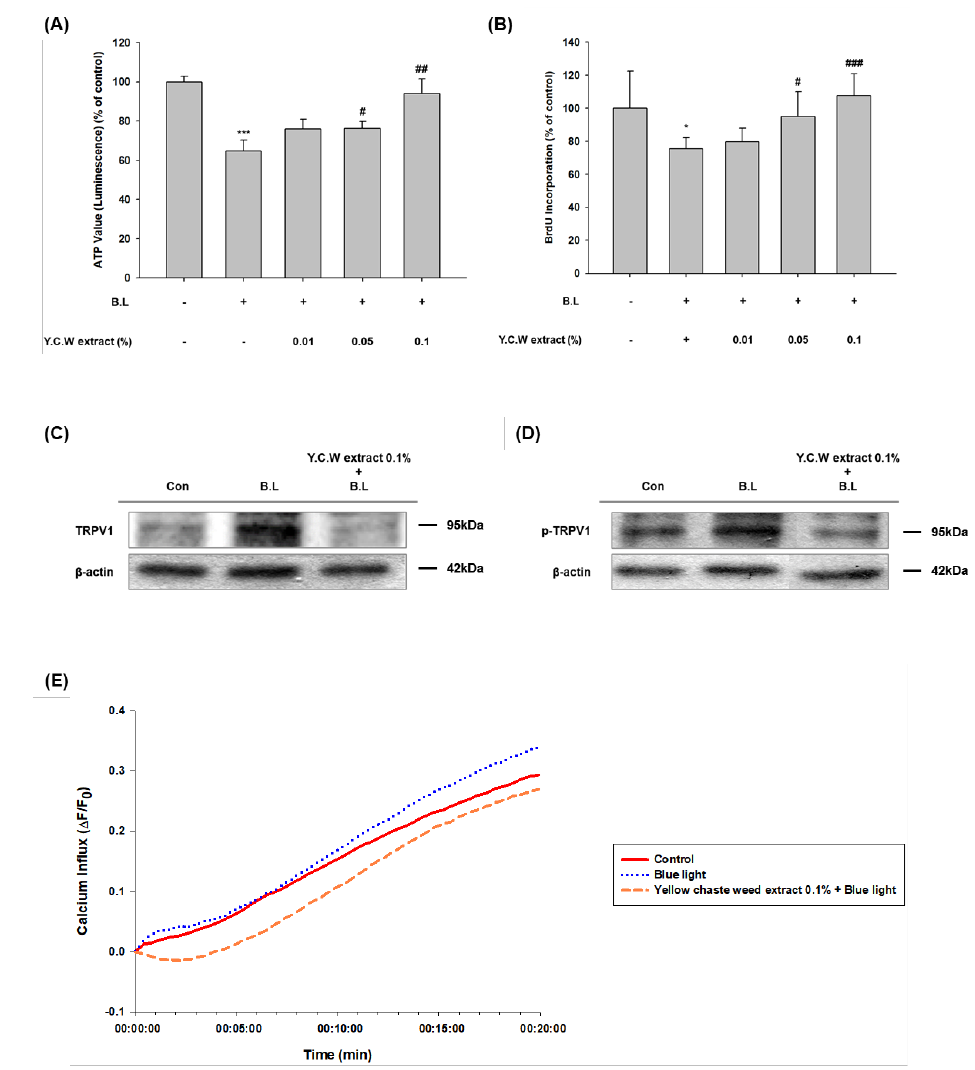
Figure 1. YCW extract increased cell proliferation via calcium dependent-TRPV1 signaling pathways in blue light irradiated HaCaT cells. ( A ) CellTiter-Glo ® 2.0 assay of YCW extract (0.01 – 0.1%) pretreated with blue light-irradiated HaCaT cells. YCW extract was pretreated 24 h before irradiation of blue light (13.68 J/cm 2 ), and the same process was repeated on the next day. After 24 h incubation, an equal volume of CellTiter-Glo reagent was added to the cells. ( B ) Cell proliferation effect of YCW extract (0.01 – 0.1%) on blue light-irradiated HaCaT cells was measured using BrdU ELISA assay. Data are presented as the mean ± SEM of four independent experiments. Statistical significance of differences among the groups was assessed by one-way analysis of variance (ANOVA), followed by Tukey’s multiple -comparison test, using the GraphPad Prism 5 software. * p < 0.05 vs. control group. * p < 0.05 vs. control, *** p < 0.005 vs. control, # p < 0.05 vs. blue light-irradiated group (B.L), ## p < 0.01 vs. B.L. ### p < 0.005 vs. B.L. ( C ) TRPV1 expression levels were determined by Western blotting at 24 h incubation after, pretreatment with YCW extract (0.1%) for and 2-day repetitive blue light irradiation (30 min, 76 W/m 2 ). ( D ) Phosphorylated-TRPV1 expression levels were determined by Western blotting at 90 min incubation after, 1 h YCW extract (0.1%) pretreatment and blue light irradiation (30 min, 76 W/m 2 ). The total proteins were extracted from the cells immediately after experimental conditions, and β -actin was used as a loading control. ( E ) Ca 2+ influx changes of blue light and with Y.C.W extract (0.1%) pretreatment by Fluo-4 NW assay. Cells were 1-h pretreated with YCW extract (0.1 %) and irradiated with blue light (10 min, 76 W/m 2 ). After the irradiation, fluorescence intensities were measured immediately over a certain period.